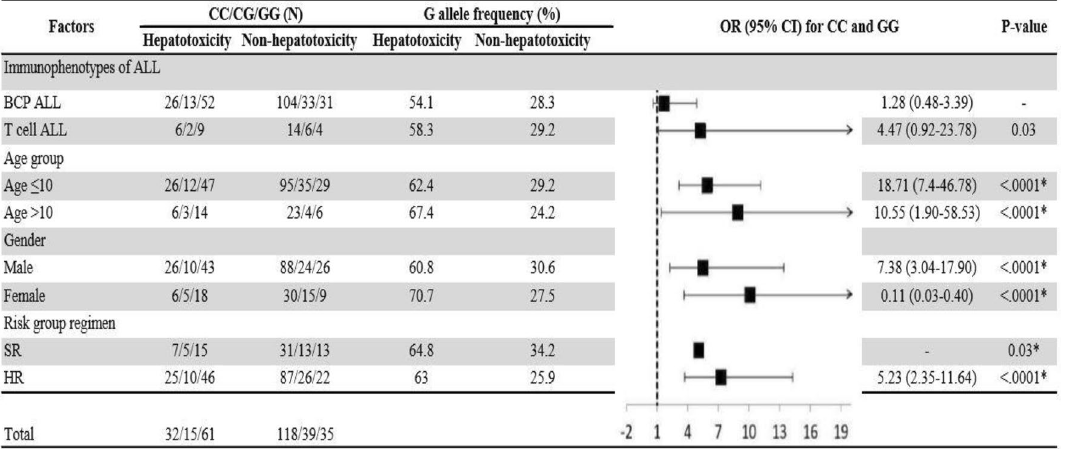
Figure 2. Adjusted association between PNPLA3 (rs738409) genotypes and risk of hepatotoxicity.